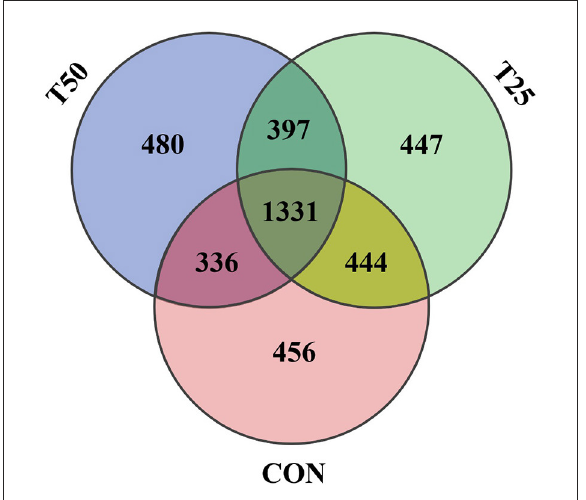
FIGURE2 Venn diagram of OTU statistics of rumen